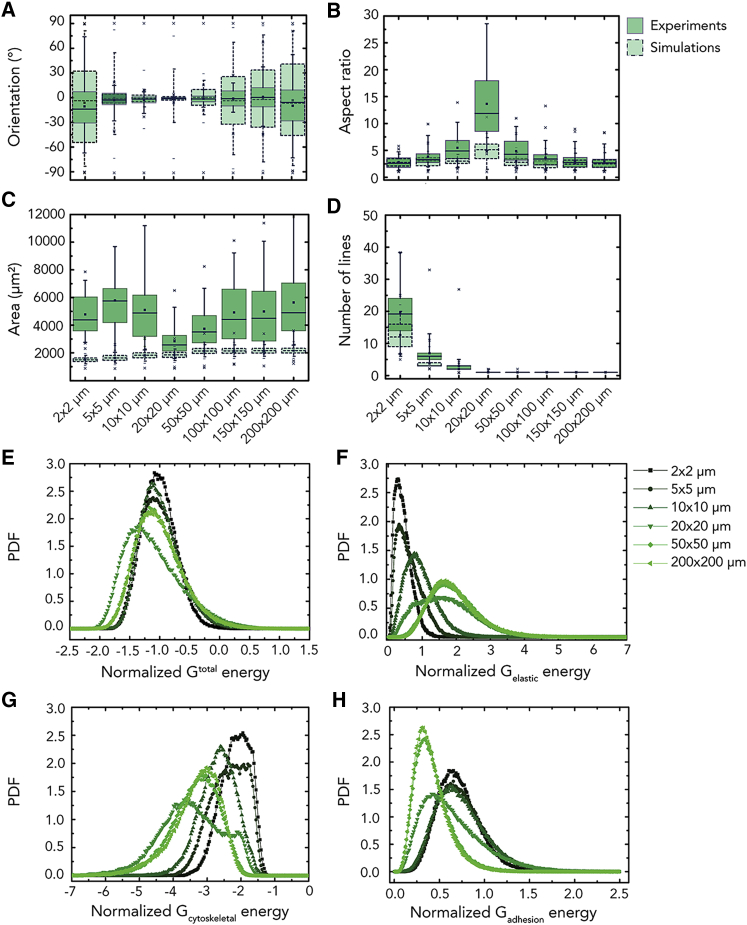
Modeling of Cellular Contact Guidance(A–D) The computational (dashed green boxes) results for myofibroblasts on parallel lines of fibronectin (2–200 μm) is compared against the corresponding experimental results (solid green boxes), in terms of the distribution of the cellular orientation (A), aspect ratio (B), area (C), and number of lines touched by single cells (D). The boxes of the boxplots represent the quartiles of the distributions, with the whiskers indicating the outliers in the experiments and the 5th and 95th percentiles of the distributions.(E–H) Probability density functions (PDFs) of the energies of myofibroblasts associated with the total Gibbs free energy (E), elasticity (F), cytoskeletal (G), and adhesion Gibbs free energy of the cell (H) are also shown. Each color represents a specific pattern of parallel lines (w × s μm). The energies are normalized by the energy of the free-standing cell. The data reported are results from three independent samples, and at least 60 cells were considered per condition.